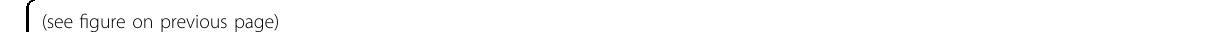
Fig. 5 PPAR γ is a potential theragnostic biomarker for GBM patients. a High PPAR γ expression is associated with poor prognosis in GBM patients. Kaplan – Meier plots were generated for GBM patient survival upon PPAR γ expression using a publicly available database. Overall survival (left, n = 206) and disease-free survival (middle, n = 162) were analyzed using data from the TCGA database or overall survival using the REMBRANDT database (right, n = 329) from http://www.betastasis.com/glioma/rembrandt/. b Distribution of PN and MES GBM patients based on PPAR γ expression levels. All GBM patients in the database from TCGA used in ( a ) were counted based on low, medium, or high PPAR γ expression levels. c Kaplan – Meier plots for overall survival (left) or disease-free survival (right) of PN and MES GBM patients in the same TCGA database. d PPAR γ expression in microdissected GBM tissues. The microdissection process was carried out to dissect tumors from the corresponding normal tissues based on MRI images (upper), which was followed by an immunoblot assay for PPAR γ (middle) and immunohistochemistry staining for PPAR γ , SOX2, and CD44 (lower). Note that two pair-matched tissues were obtained from GBM patients. The scale bar represents 50 μ m. e IHC of human high-grade glioma for PPAR γ , SOX2, and CD44. The scale bar represents 50 μ m.